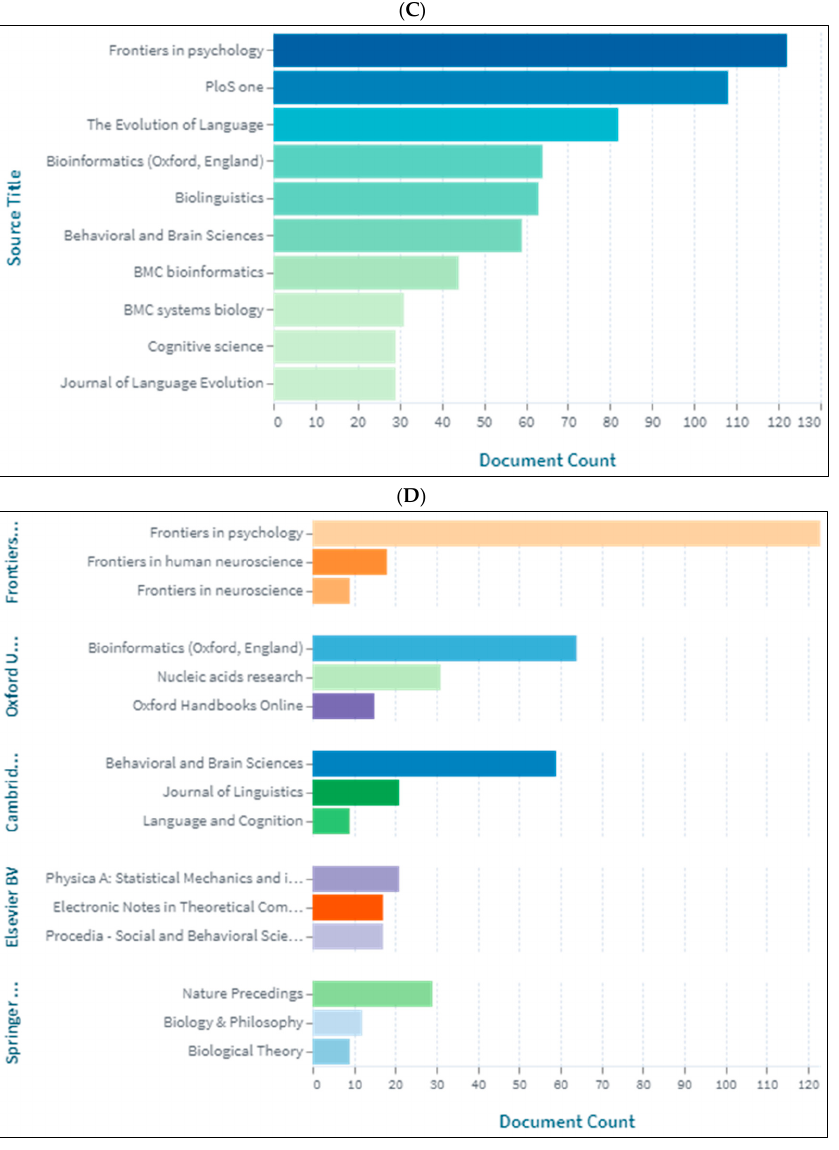
Figure 4. Knowledge production size in biolinguistics by journal. ( A ) (Scopus), ( B ) (WOS), ( C ) (Lens), ( D ) (Lens).